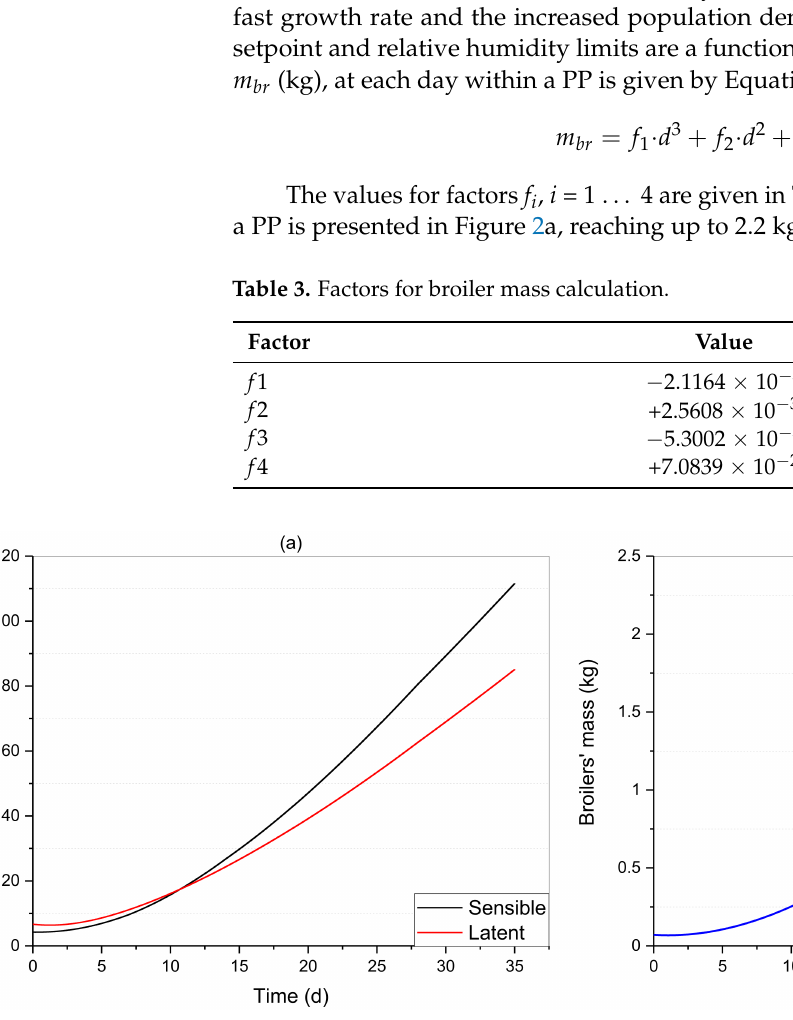
Figure 2. Increase in ( a ) broilers’ sensible and latent thermal loads of the flock and ( b ) mass during a 35-day production period